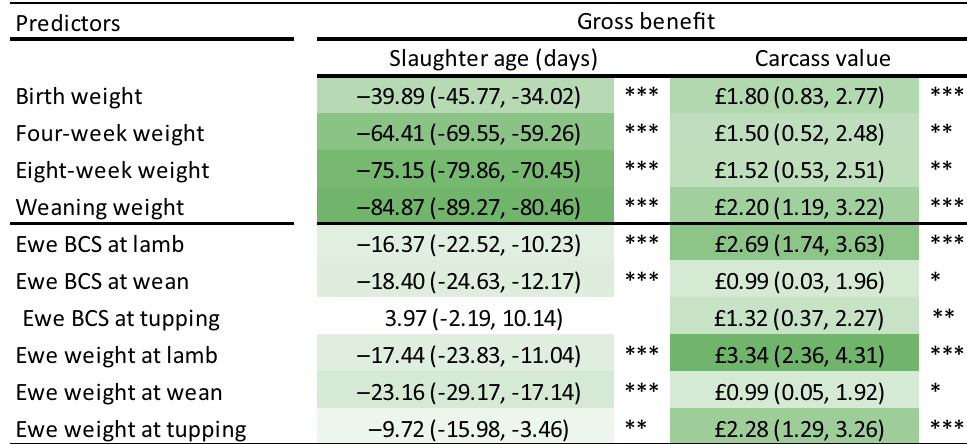
Table 2. Gross information values of individual predictors. Darker shades indicate higher information values. Confidence intervals (95%) shown in parentheses. Significance codes: *** p < 0.001; ** p < 0.01; * p <